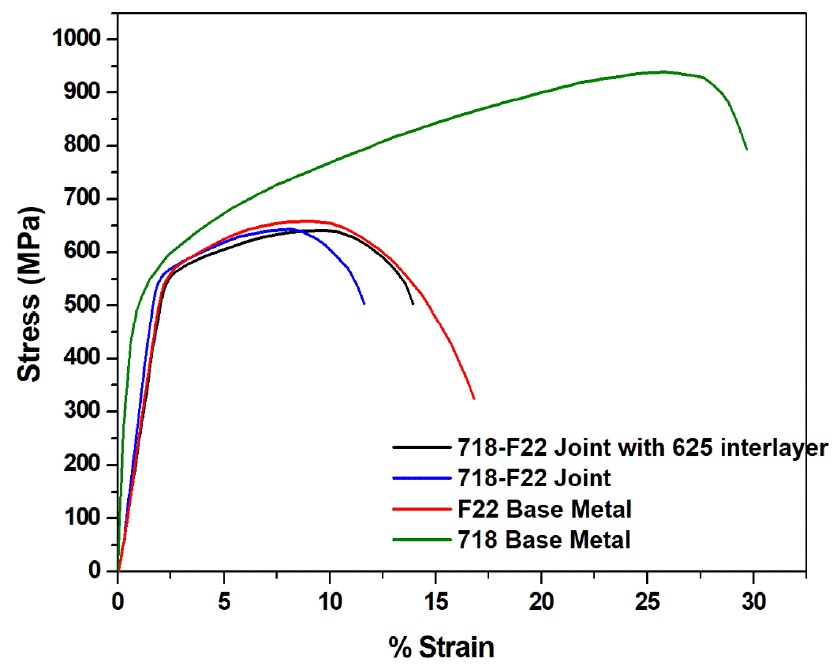
Figure 9. Typical tensile curves of base metals and friction weld joints.